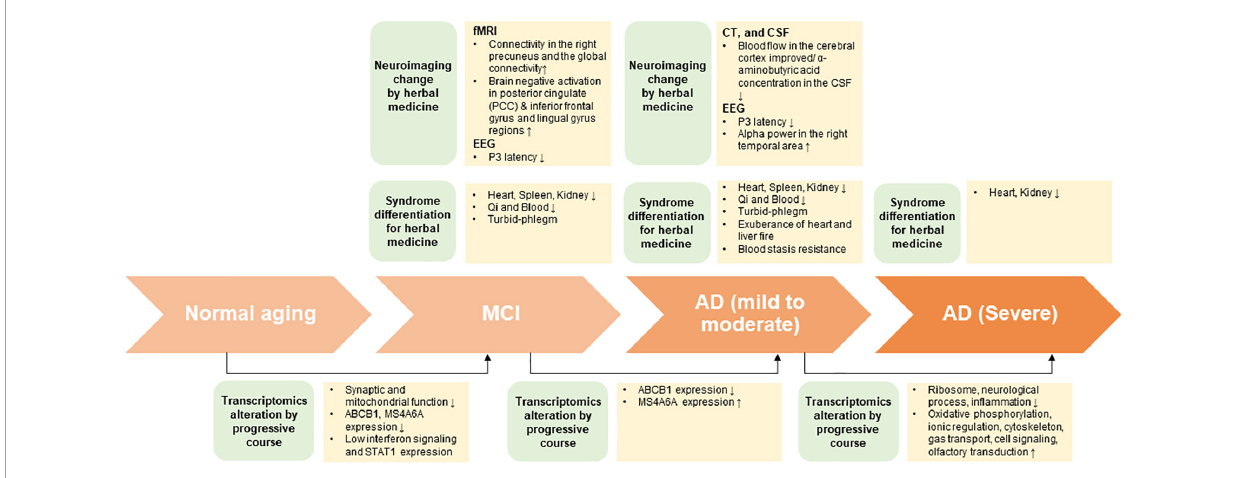
FIGURE1 The summary on potential interdisciplinary biomarkers and syndrome differentiation diagnosis according to progressive course of cognitive impairment.